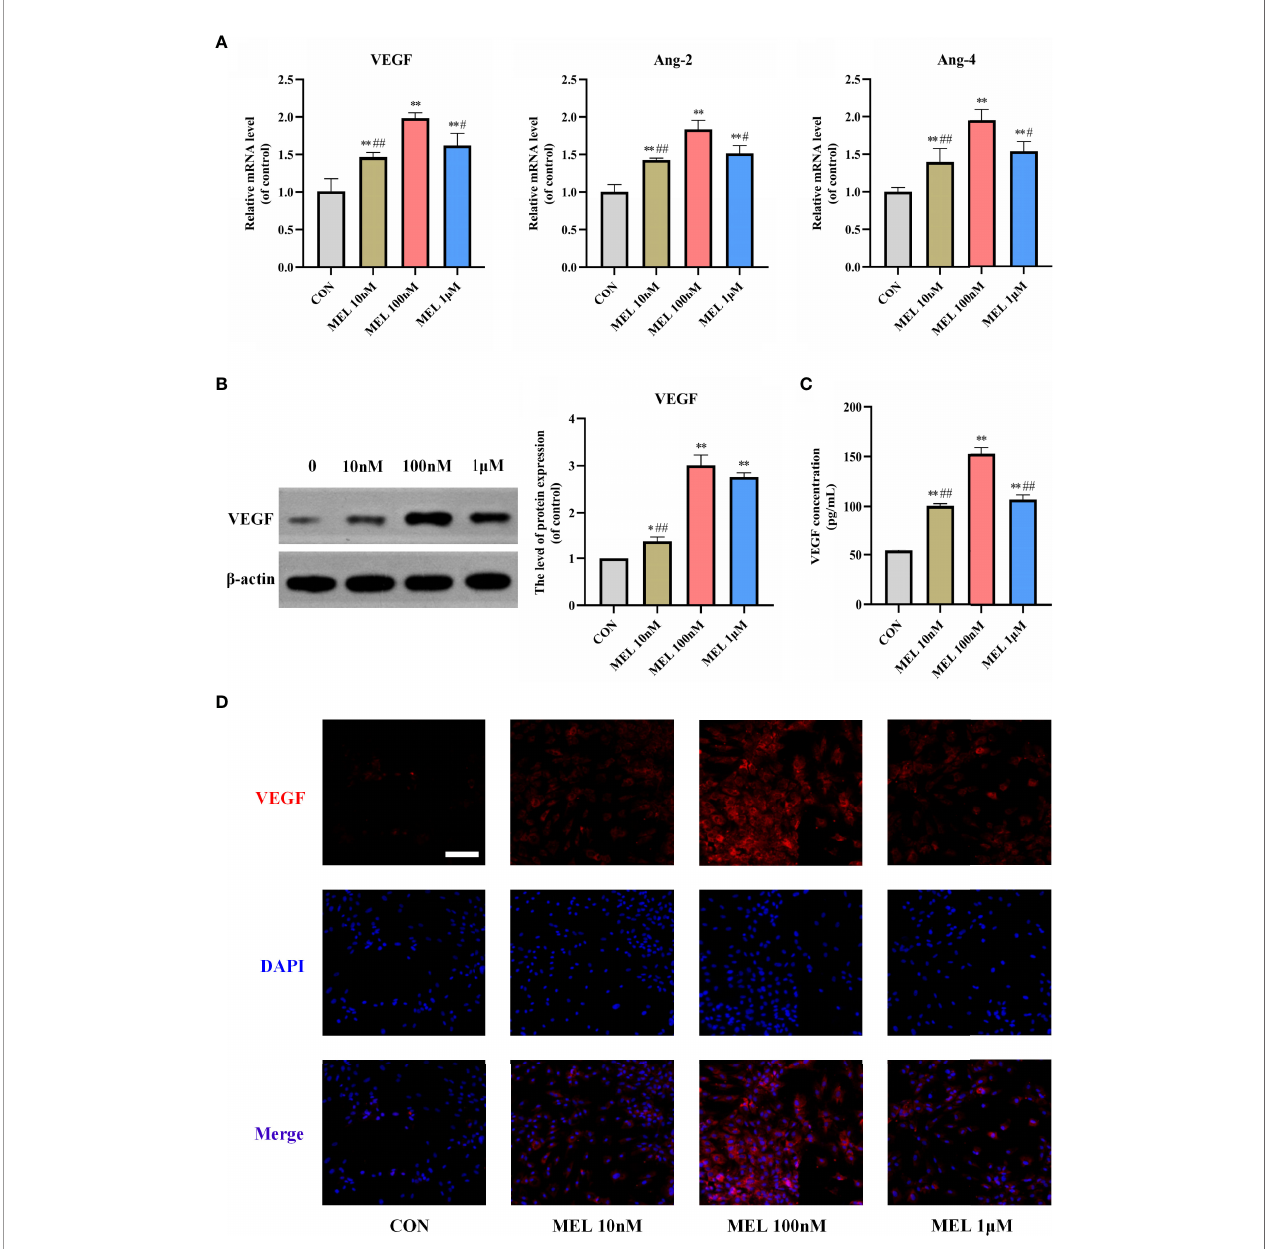
FIGURE 2 | Melatonin promoted angiogenesis in vitro . (A) mRNA expression levels of osteogenesis-related markers in BMSCs following treatment with/without melatonin. (B) Protein expression levels of osteogenesis-related marker VEGF. (C) VEGF content secreted in the supernatant liquid assessed by ELISA kits. (D) Immuno fl uorescent images of BMSCs stained for VEGF (scale bars, 100 m m). All the experiments were repeated at least 3 times independently. BMSCs, bone marrow mesenchymal stem cells; VEGF, vascular endothelial growth factor. The data are presented as means ± SEM. * p < 0.05, ** p < 0.01 vs . control group, # p < 0.05, ## p < 0.01 vs . 100 nM melatonin